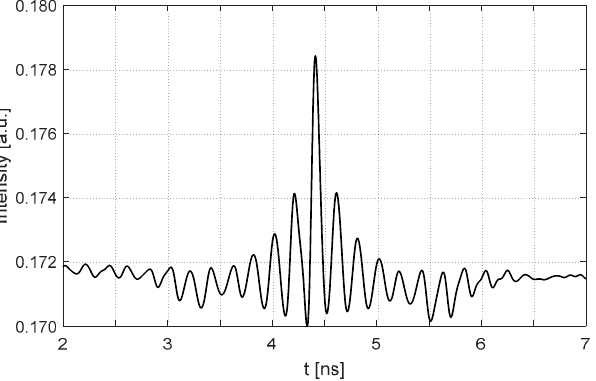
Figure 7 . Typical laser transient intensity under quasi-continuous wave (QCW) mode.